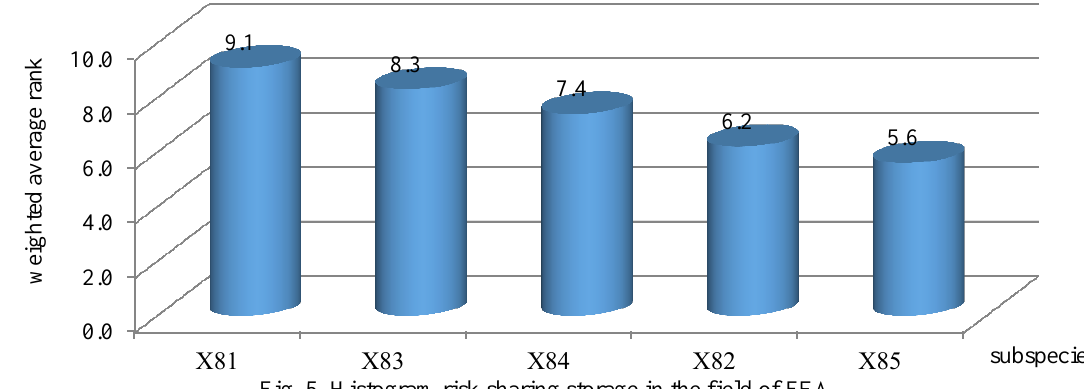
Fig. 5. Histogram risk sharing storage in the field of